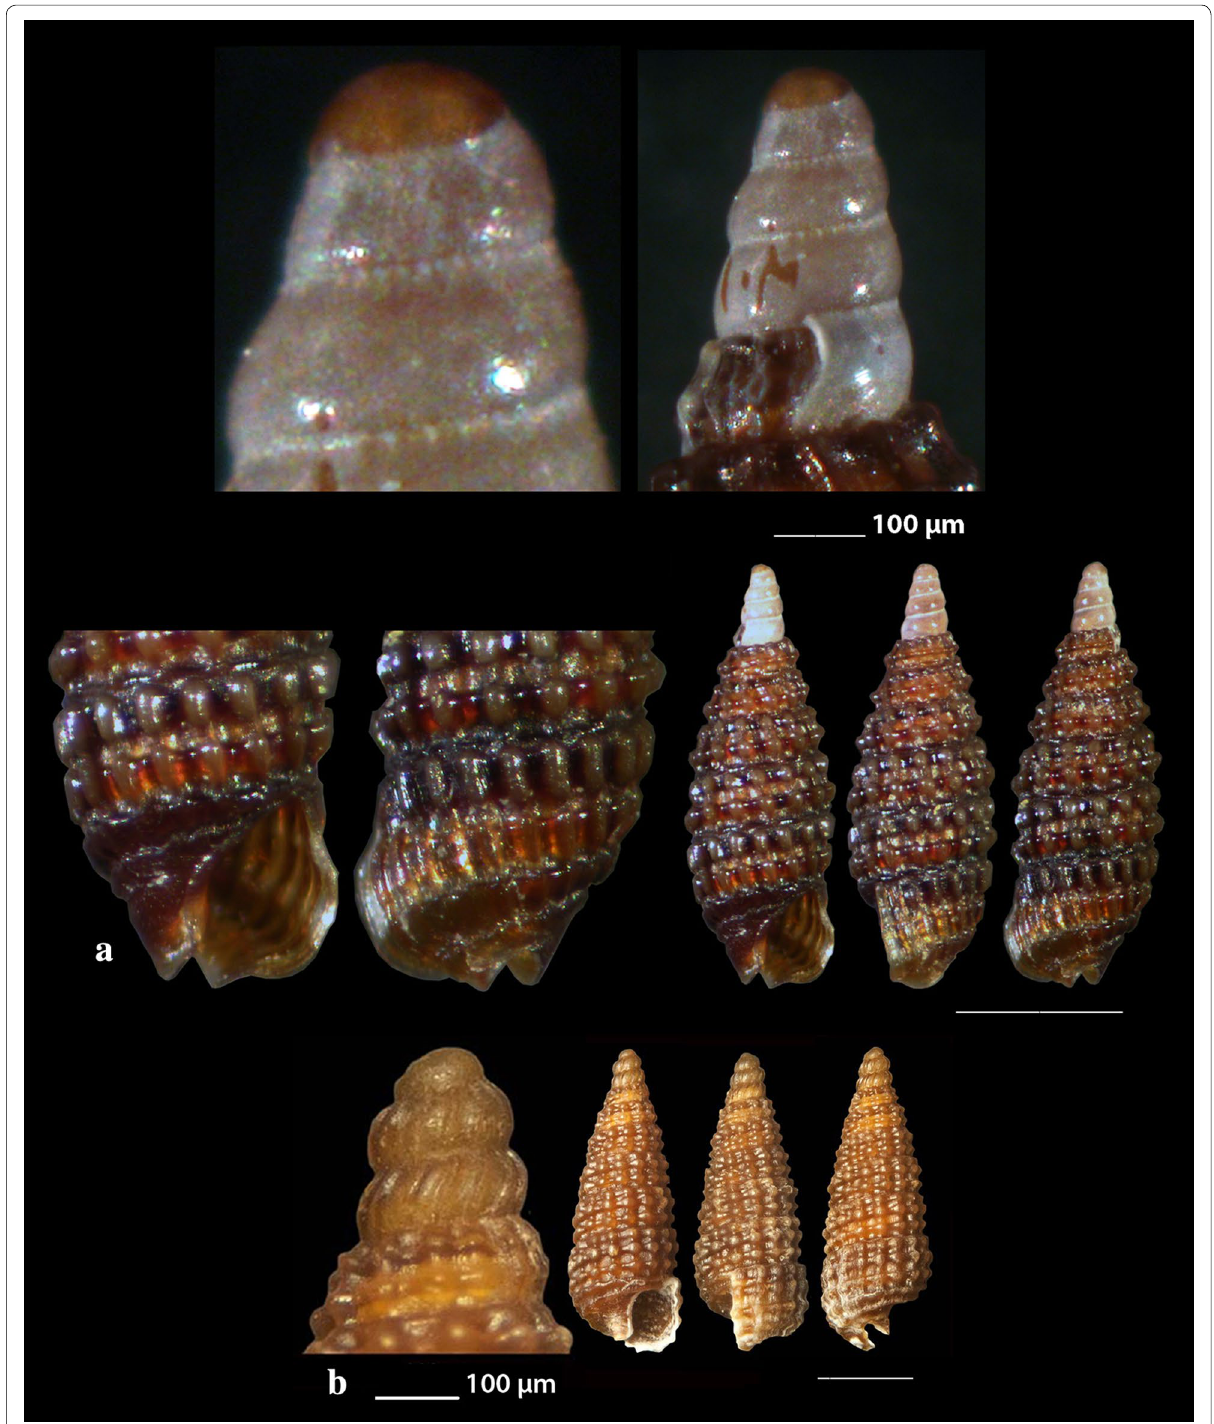
Fig. 14 a Horologica sp., b Krachia tiara . Bar